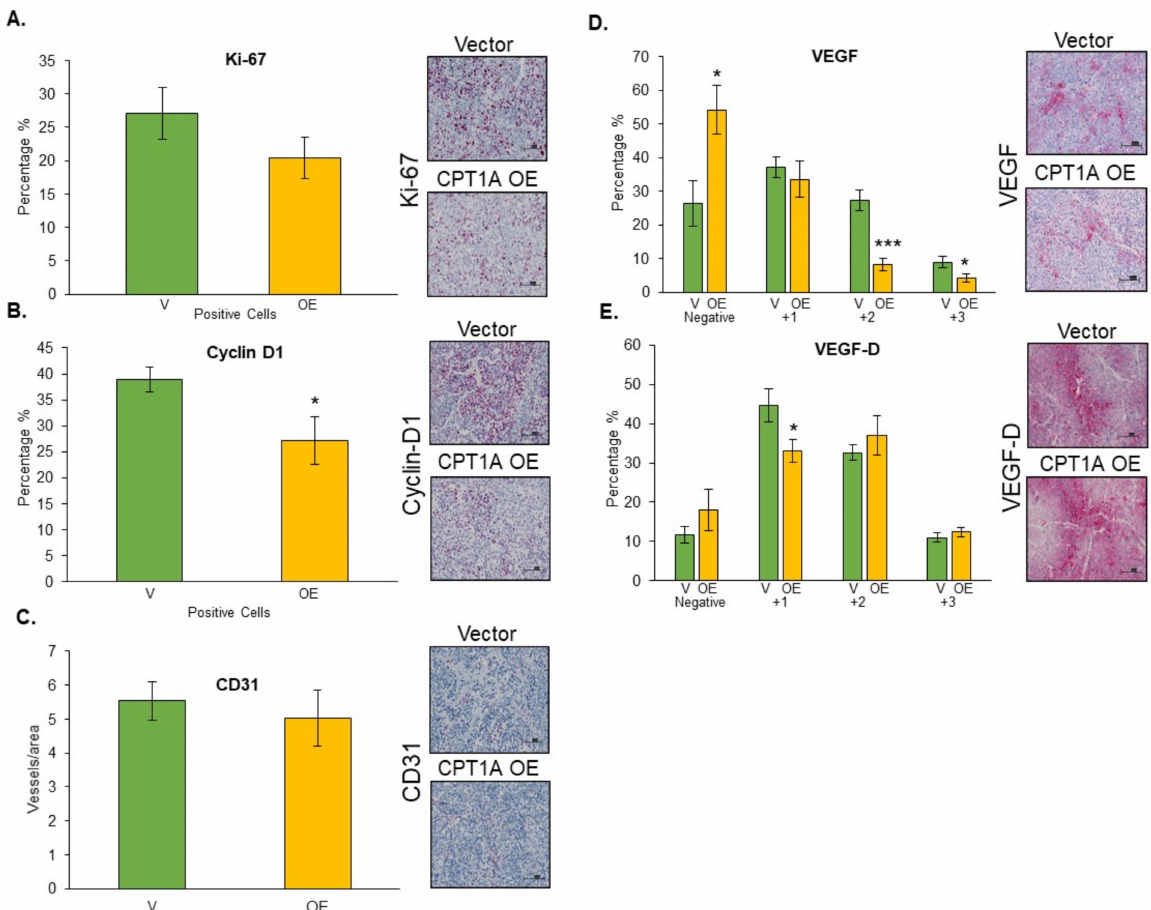
Figure 7. The effect of CPT1A overexpression on proliferation and angiogenesis in 22Rv1 tumors. Tumor tissues from mice bearing vector controls or CPT1A overexpressing 22Rv1 tumors were stained to assess various biomarkers by IHC as described in the Methods. Representative images at 20 × magnification and quantified data are presented for ( A ) Ki67 (vector n = 8, OE n = 8), ( B ) Cyclin D1 (vector n = 8, OE n = 8) (* p < 0.001), ( C ) CD31 (Vector n = 8, OE n = 8), ( D ) VEGF (Vector n = 8, OE n = 8) (* p < 0.04), and ( E ) VEGF-D (Vector n = 8, OE n = 7) (* p < 0.013, *** p < 0.0002, * p < 0.04). IHC data are presented as means ± SEM. Scale bar = 100 µ